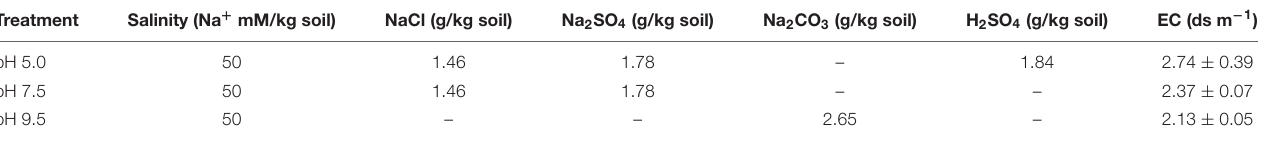
TABLE 1 | Salt content and soil electrical conductivity (EC) of different pH treatment.